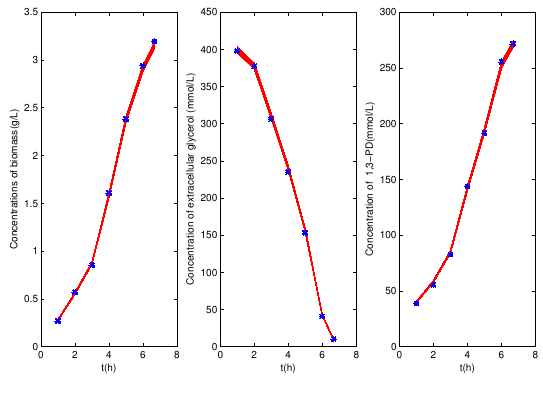
Figure 3. Comparison of biomass, glycerol, 1,3-PD concentration between experimental data and computational results x ( t,x 3